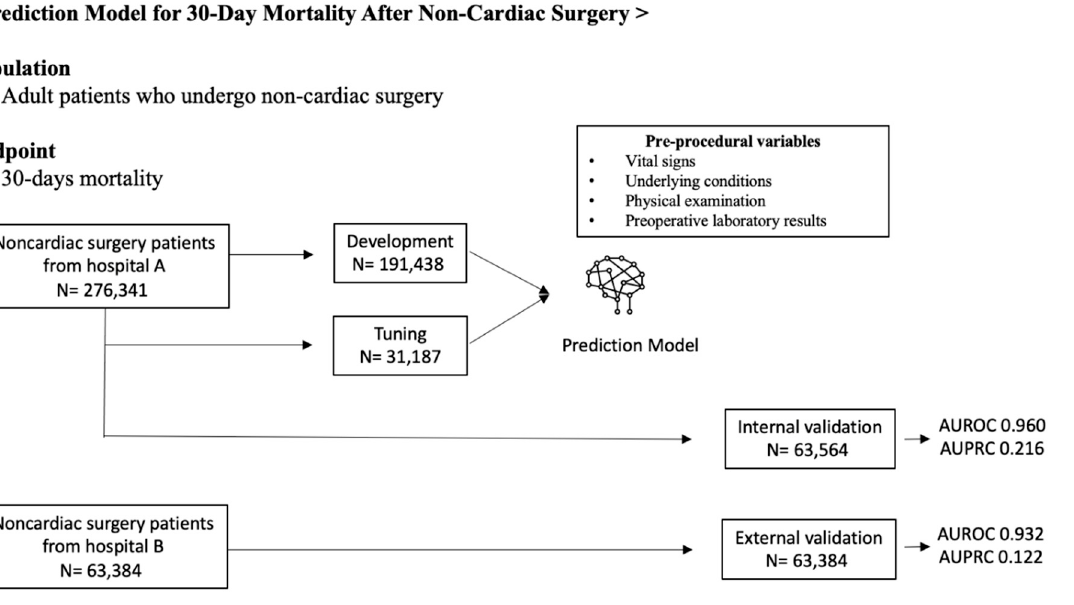
Figure 1. Overview of study. AUROC denotes the area under the receiver operating characteristic curve). AUPRC indicates the area under the precision and recall curve. Table 1. Preoperative variables used in the prediction model.